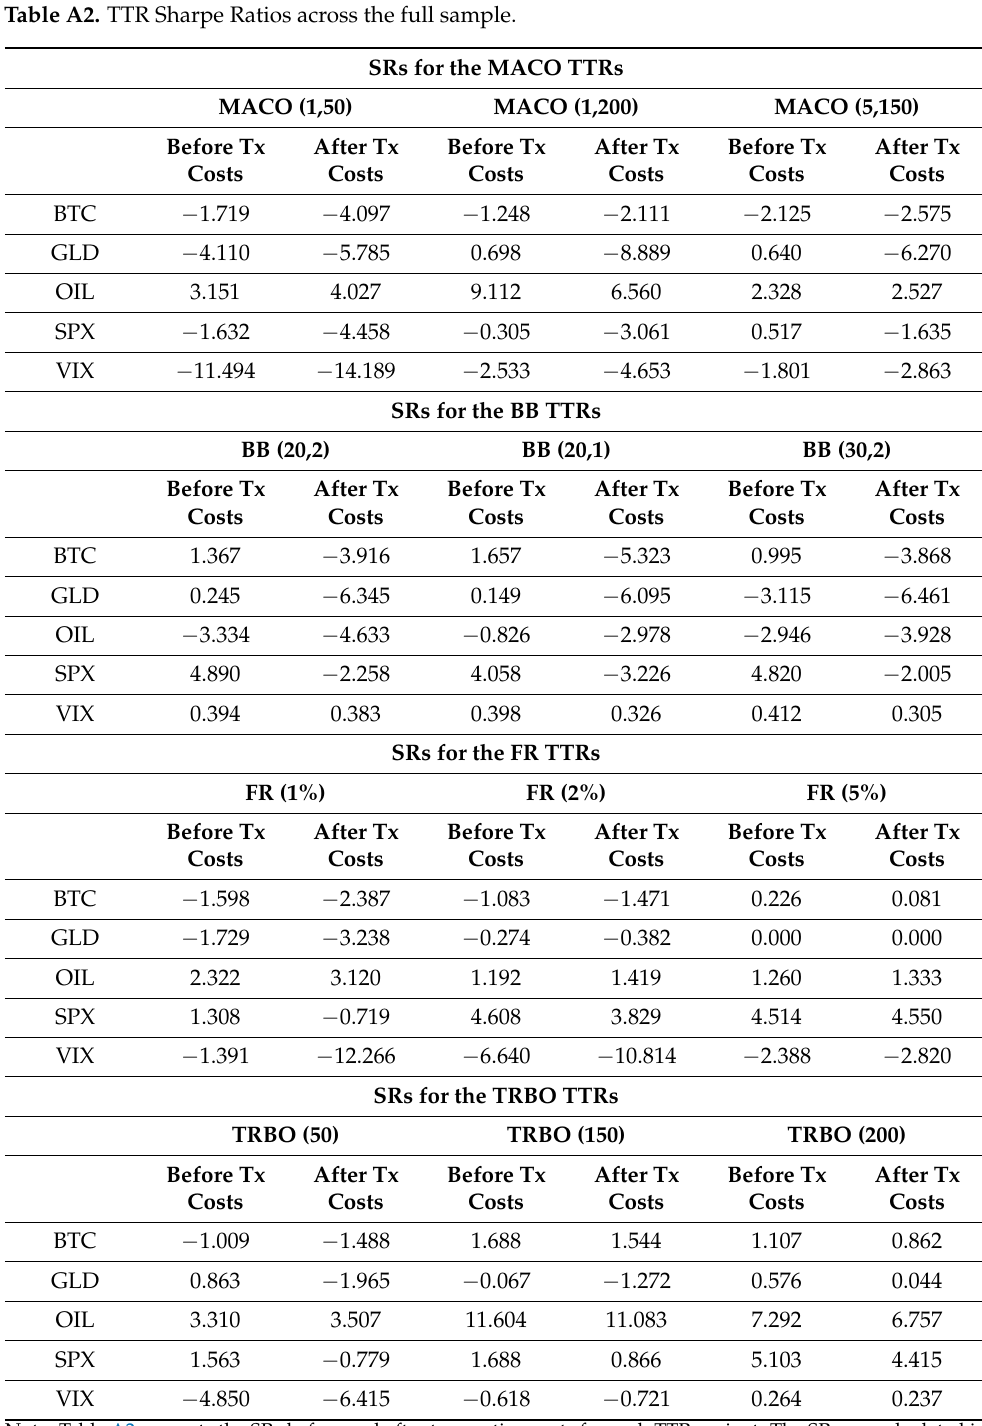
Table A2. TTR Sharpe Ratios across the full